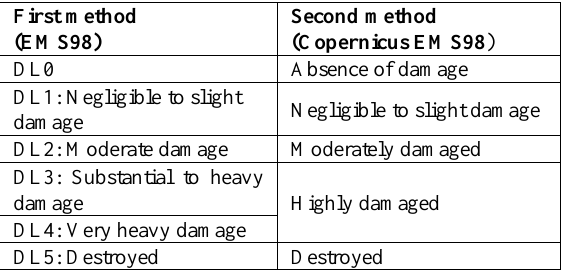
Table 3. Comparison between DDEs. DL3 and DL4 (1 st method) both correspond to the class “highly damaged” (2 nd method).